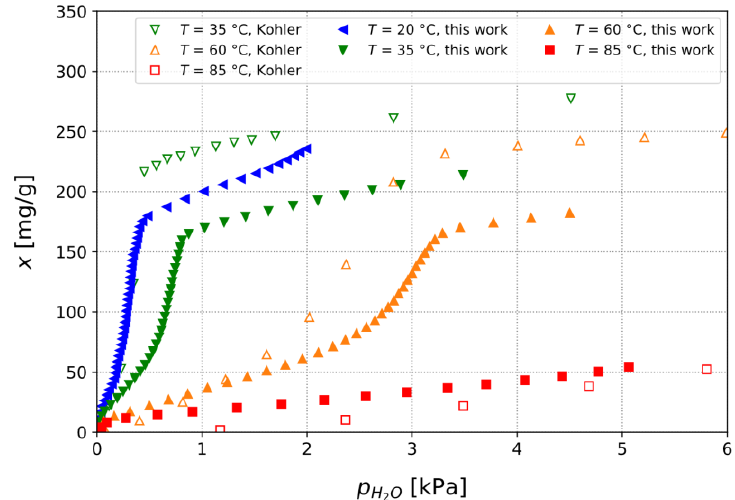
Figure 8. Comparison of measured adsorption isotherms with literature data from Kohler [14].